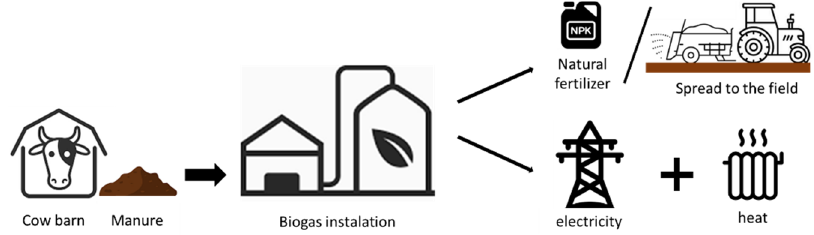
Figure 2. Scheme of Scenario II.